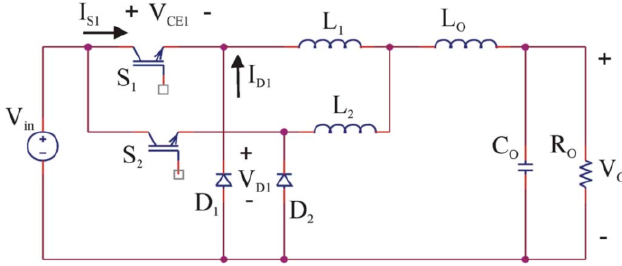
Fig. 7. Interleaved zero-current-transition (ZCT) buck converter